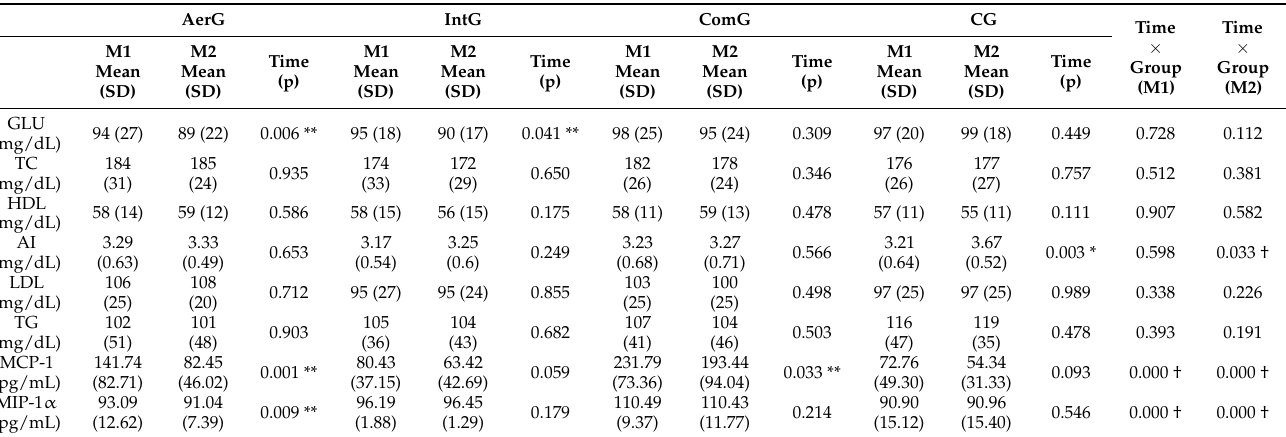
Table 2. IMT and Hemodynamic parameters results.